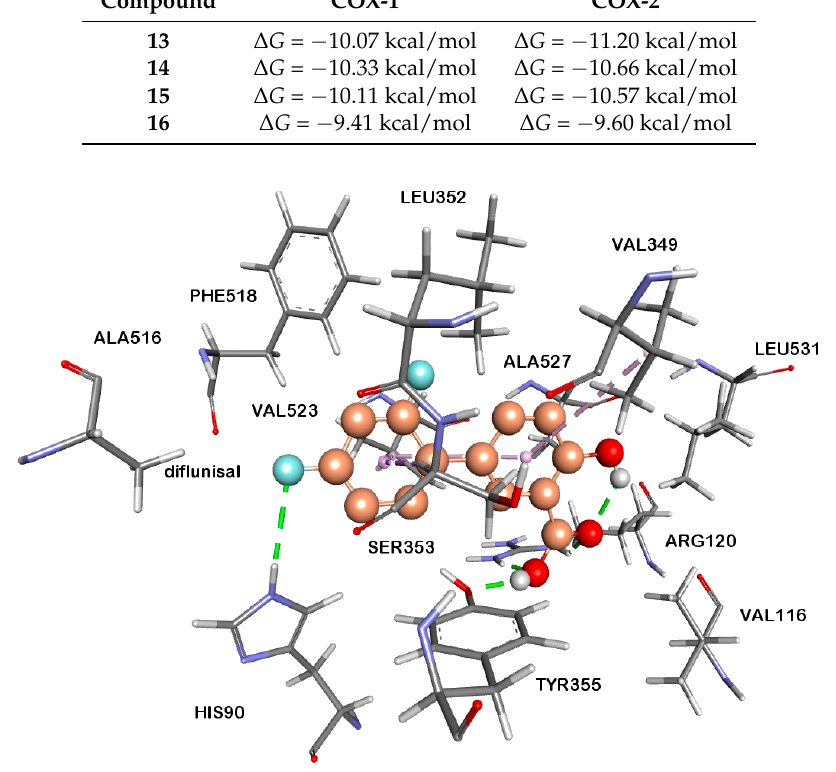
Figure 4. 3D representation of predicted binding mode and protein-ligand interactions of diflunisal to COX-2 enzyme. H-bonds occur between hydroxyl groups of hydroxybenzoic acid part of diflunisal and TYR355 and ARG120 amino acid side chains and HIS90 monocation with the fluoro substituent of the fluorophenyl